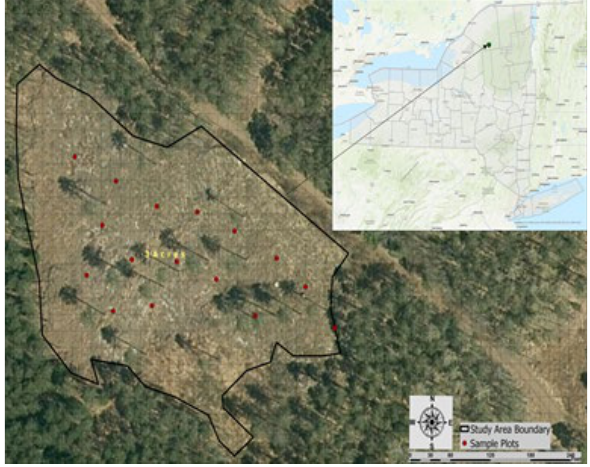
Figure 1 : Location of the study area